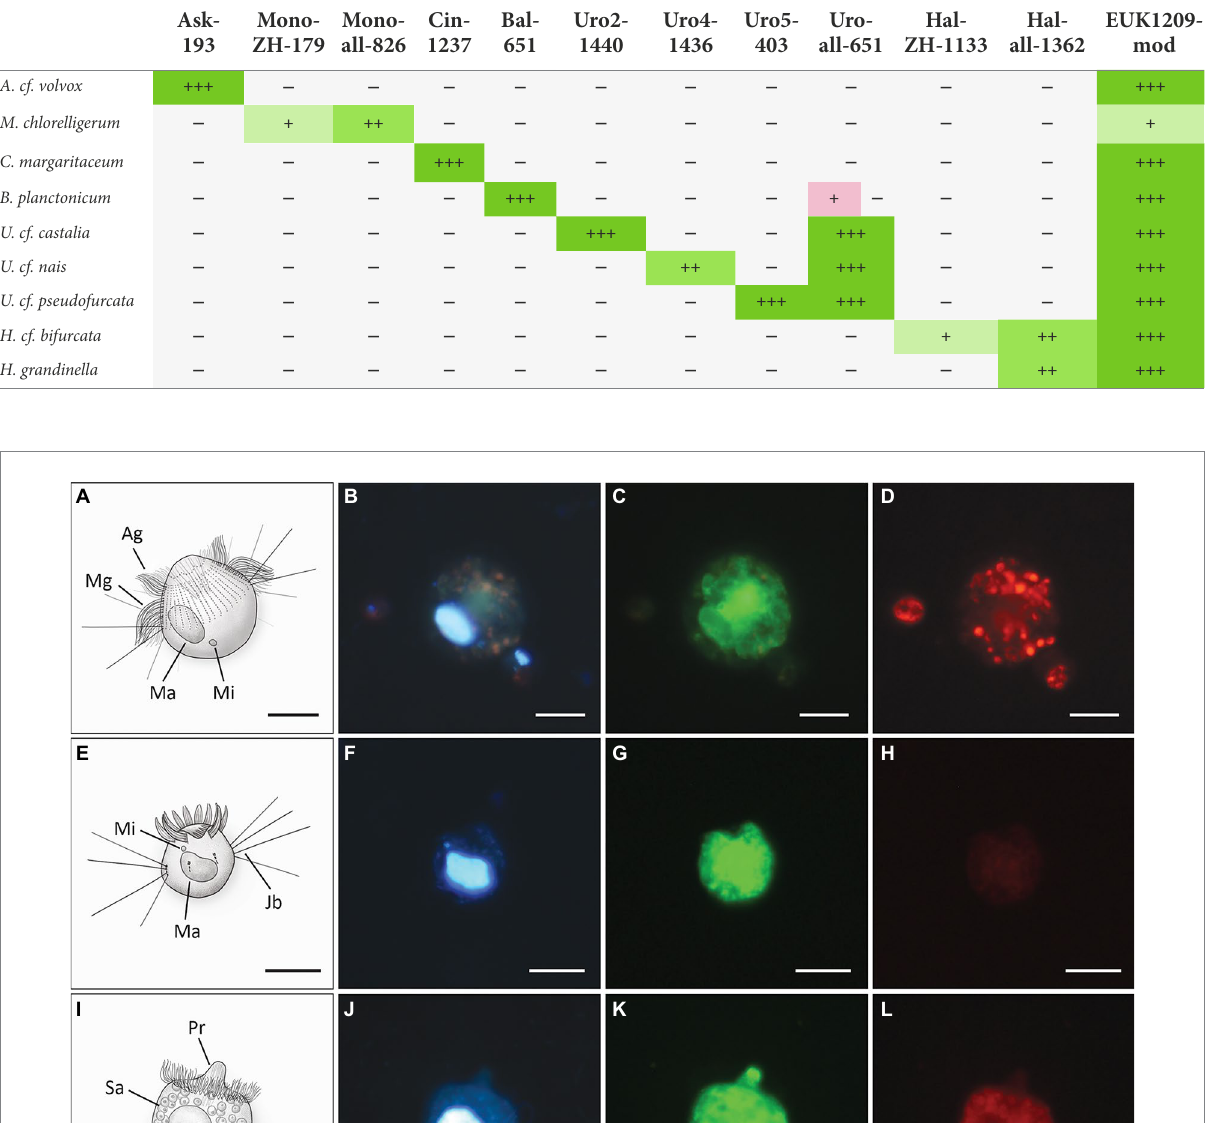
TABLE 2 Specificity of CARD-FISH probes. All nine studied ciliate species (first column) versus all 12 tested oligonucleotide probes (first row). Positive signals of hybridized cells are highlighted in green and false positive signals are highlighted in red. Signal intensity: +++ strong, ++ moderate, + weak. Grey: - no signal.